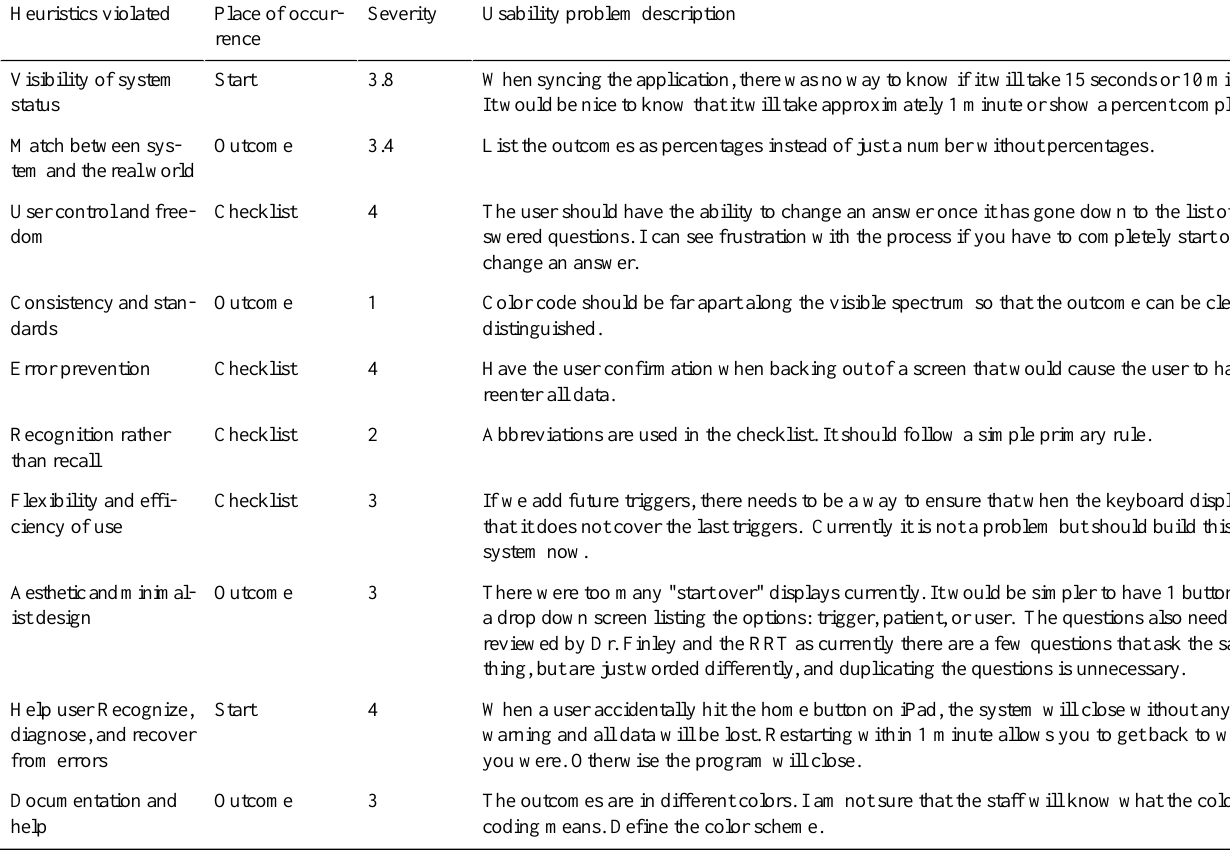
Table 1. Example heuristic